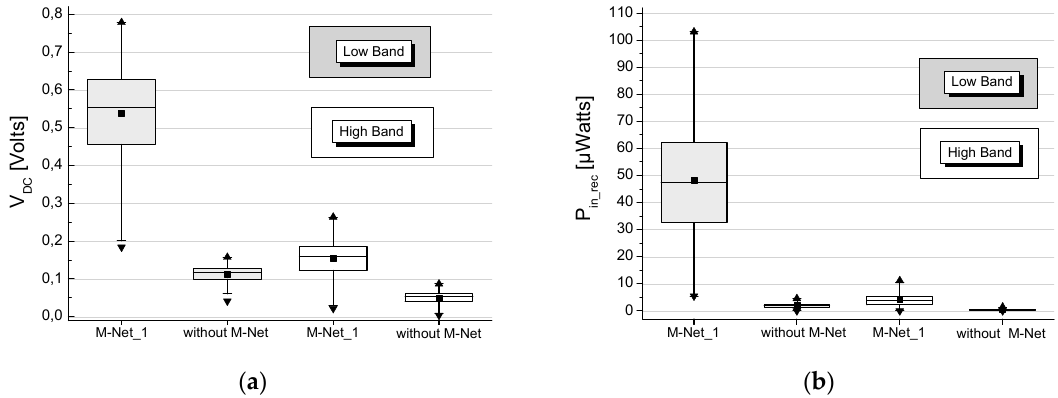
Figure 15. With M-Net_1: statistical results over frequencies in the matching bands, the DoAs and both rectifiers for a) V DC b) P in_rec.